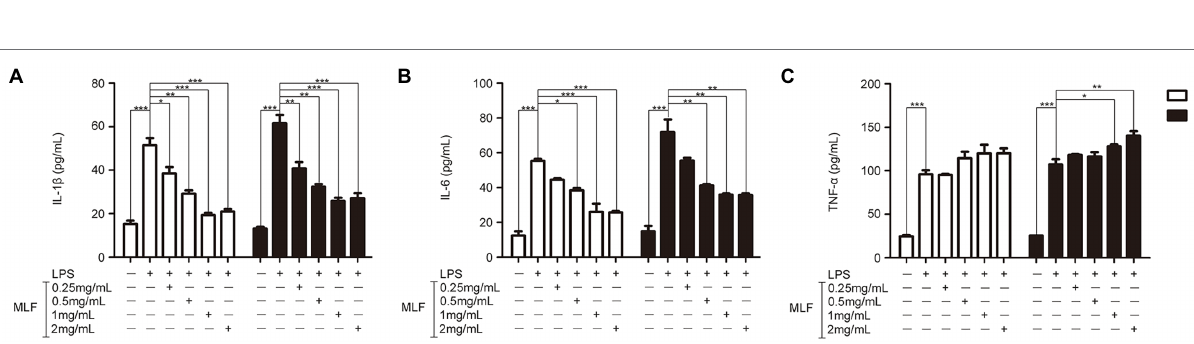
FIGURE 2 | The protein levels of IL-1 β , IL-6, and TNF- α in caco-2 cells. IL-1 β (A) , IL-6 (B) , and TNF- α (C) levels were examined in the supernatant of Caco-2 cells which were pretreated with 50 μ g/ml lipopolysaccharide (LPS) for 12 h, then treated with MLF (0.25, 0.5, 1, and 2 mg/ml) for 12 or 24 h. All groups were statistically analyzed with the LPS group. Data are expressed as means ± S.E. * p < 0.05, ** p < 0.01, and *** p <